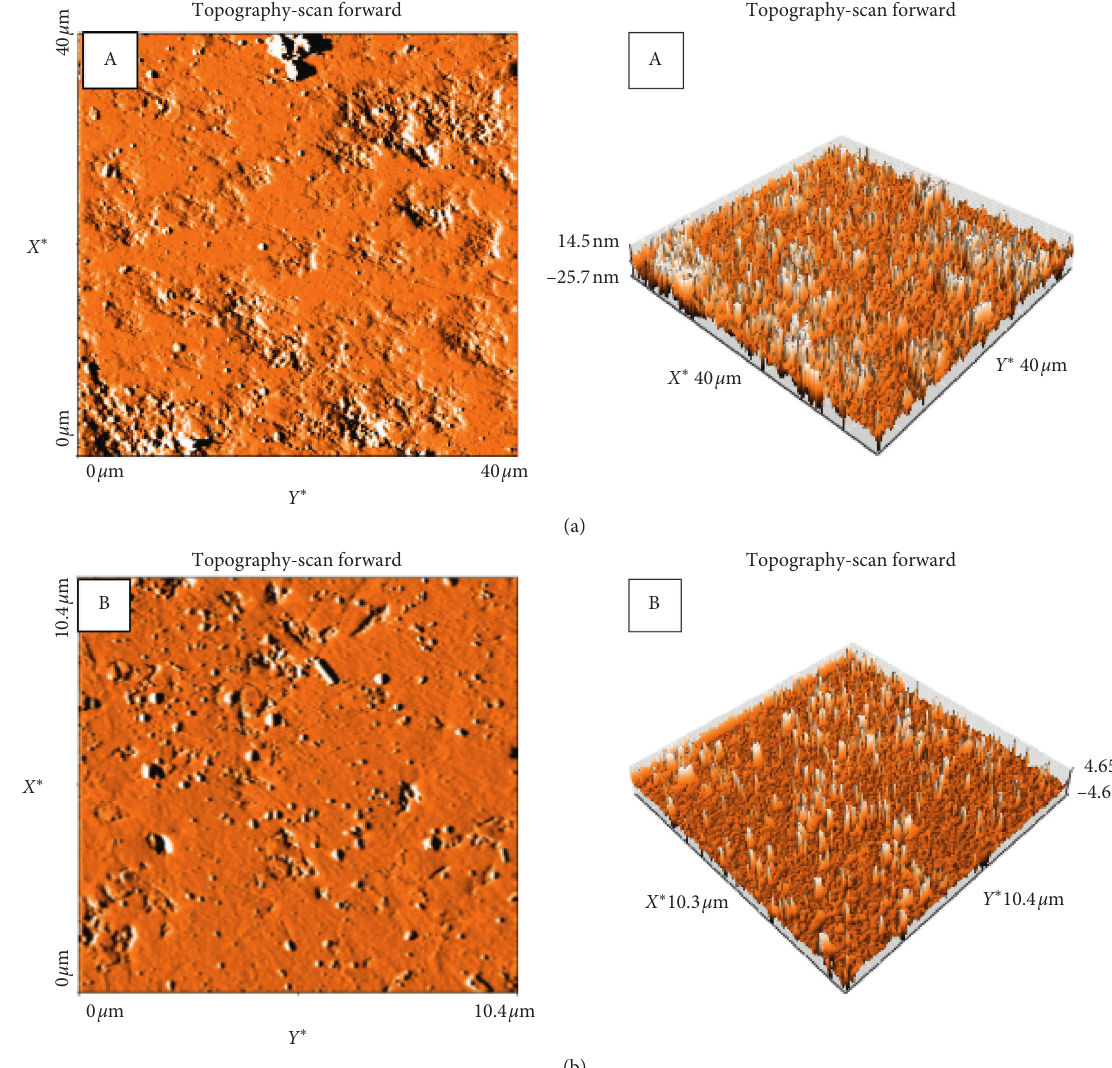
Figure 5: Topography (3D images) of granite Gris Pinhel (a) and granite Rosa Porrino (b). Table 1: Roughness values of Gris Pinhel and Rosa Porrino. Granite